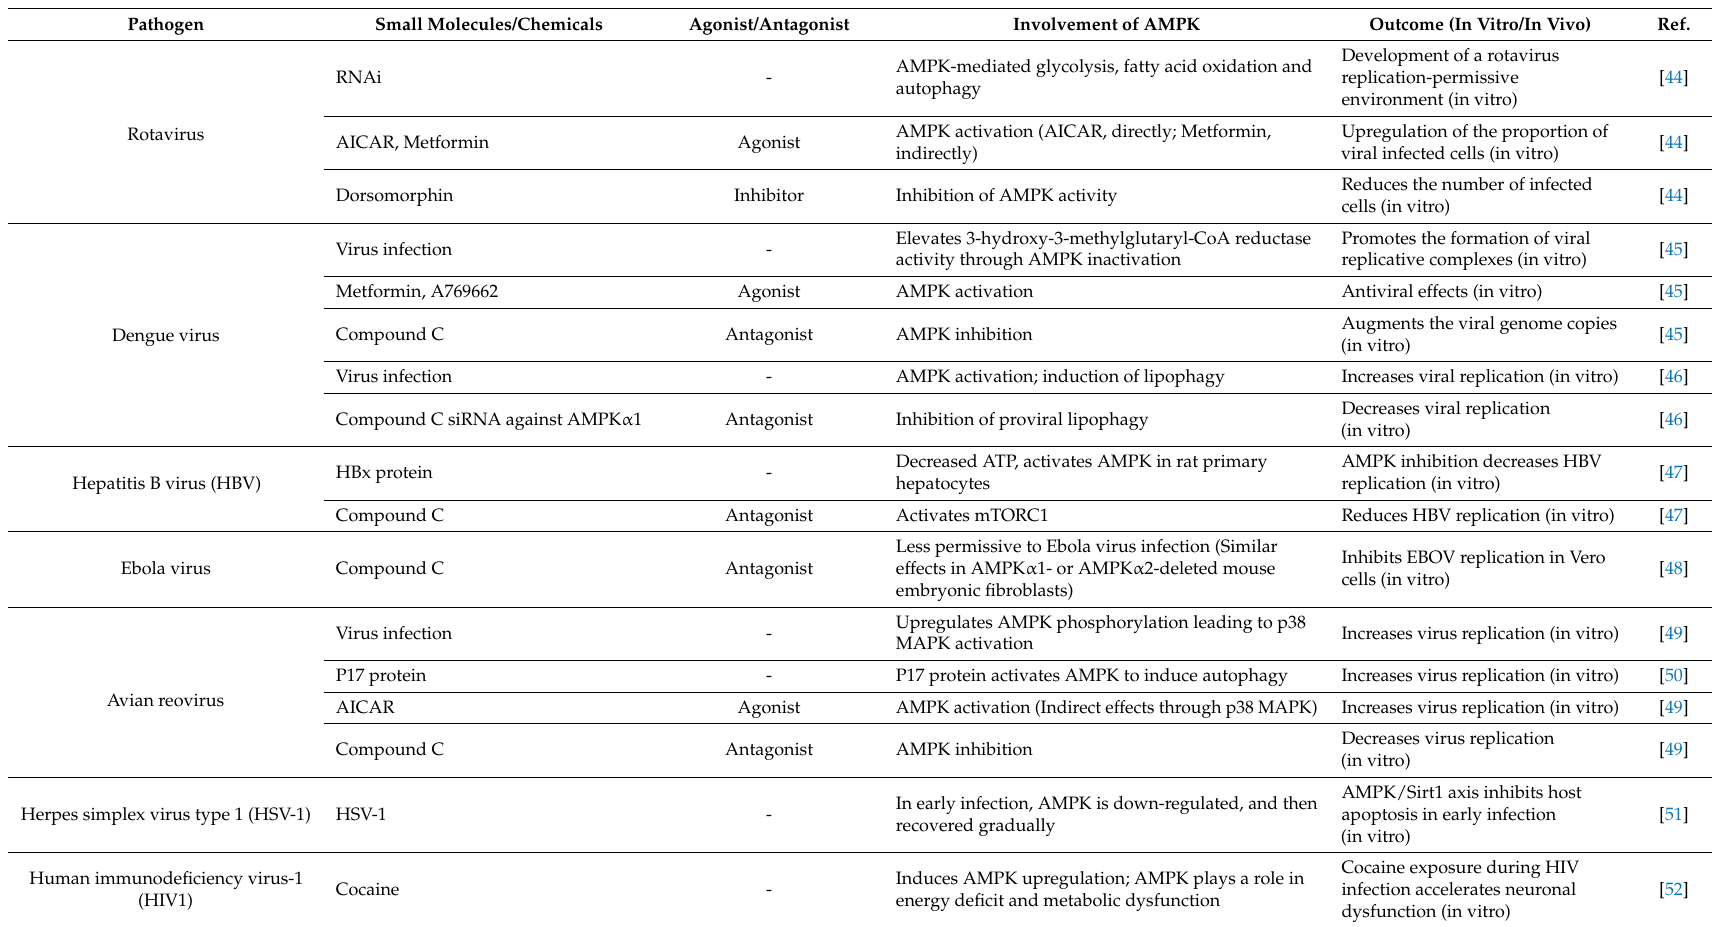
Table 2. Detrimental Effects of AMPK in viral